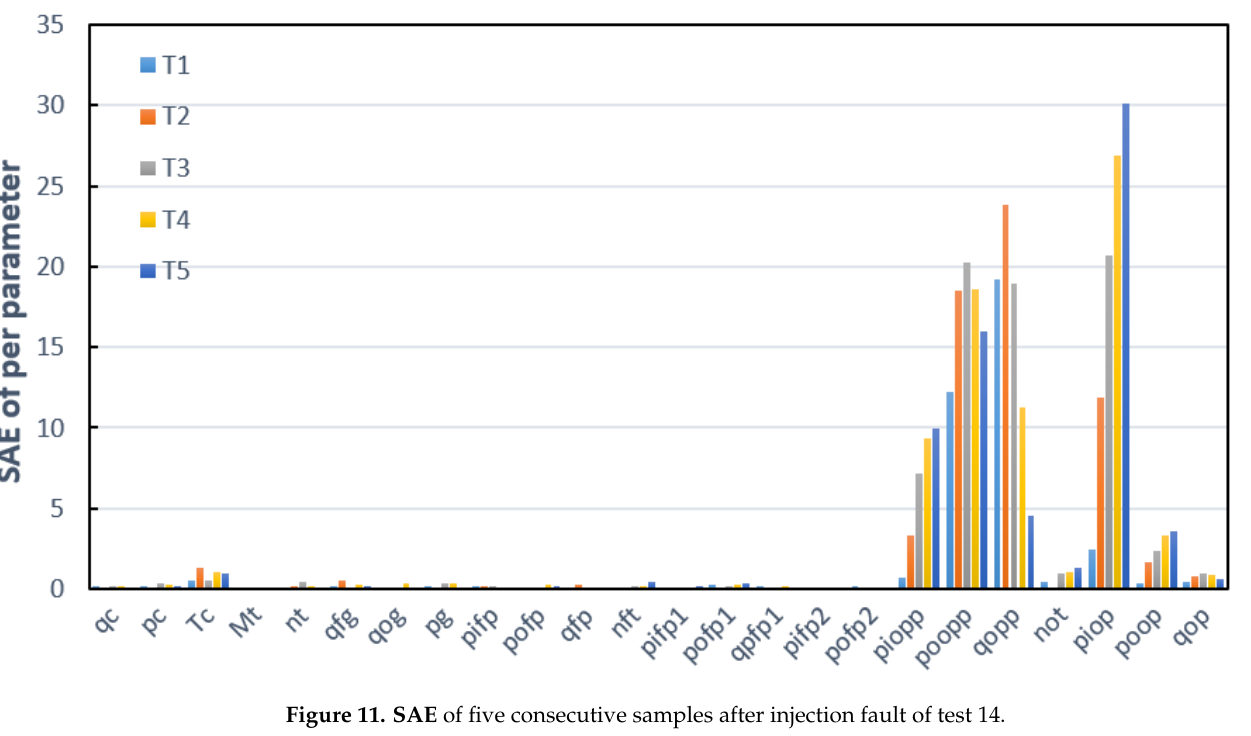
Figure 10. SAE of five consecutive samples after injection fault of test 13.